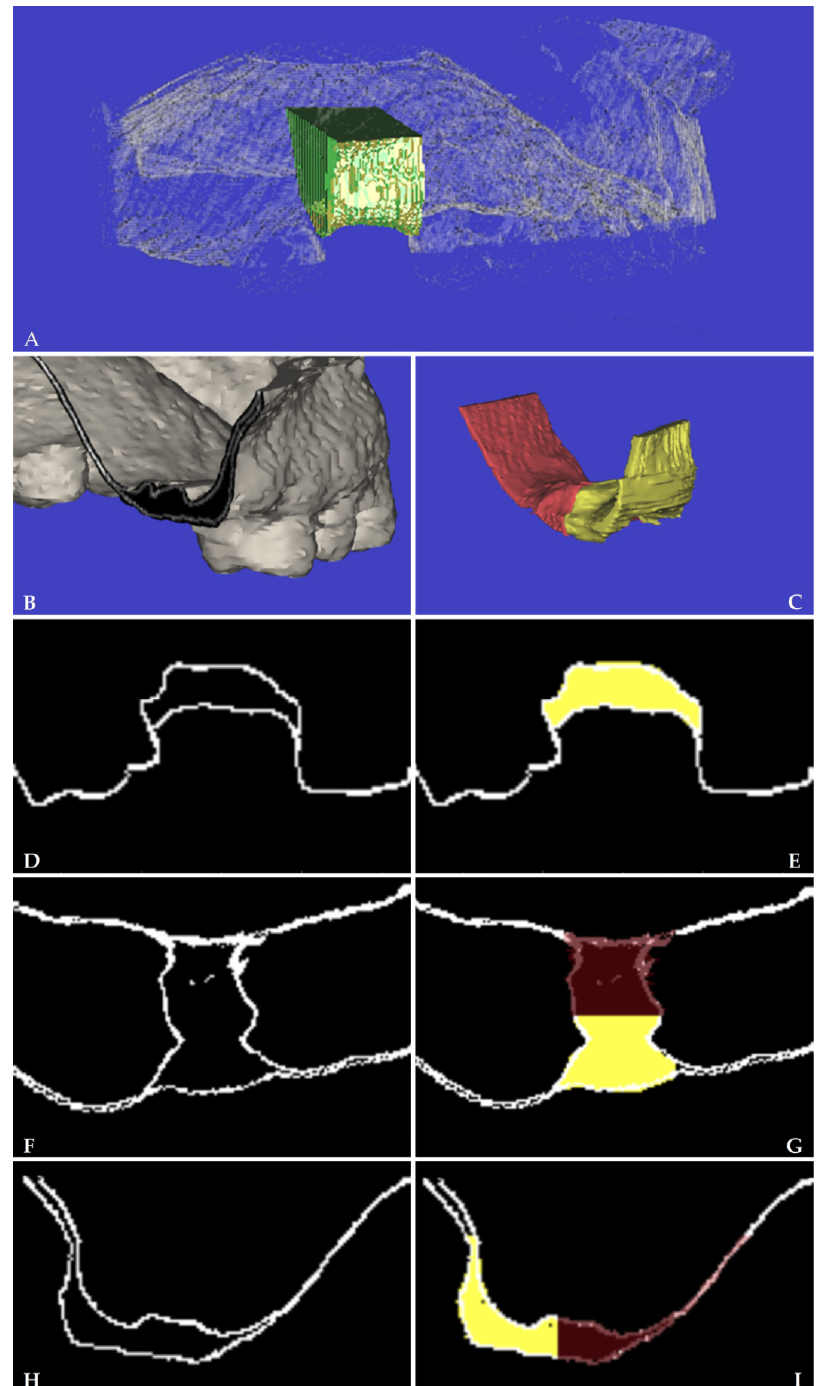
Figure 1. Buccal and palatal volume measurements ( A ) Three-dimensional voxelized .stl cloud with measured alveolar ridge volume at T0 (in green) and basal surface (in dark green) within the Volume Of Interest, ( B ) isometric rendering of two fused voxelized .stl clouds (intraoperative versus 4-month survey) with ( C ) view of the change of alveolar ridge volume, buccal (in yellow) and palatal (in red). ( D , E ) sagittal, ( F , G ) axial, and ( H , I ) cross-sectional views of the clouds obtained by an intraoral optical scanner.